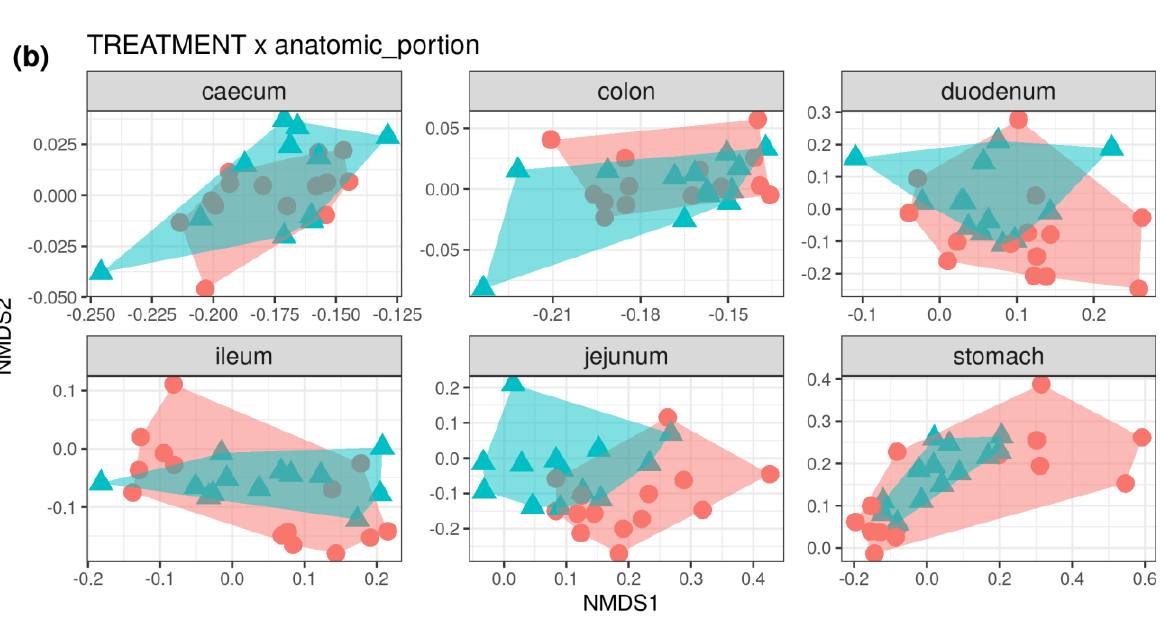
Figure 6. ( a ): Non-metric multidimensional scaling plot of Bray-Curtis dissimilarities estimated from the OTU table. The plots show the first three NMDS dimensions (from left to right: dimensions one and two, one and three, two and three). Control samples in red circles, Goji-treated samples in blue triangles. ( b ): First two dimensions from the non-metric dimensional scaling of Bray-Curtis dissimilarities between control and Goji-treated samples along the digestive tract of rabbits. For the analyses, 14 and 11–13 samples were used for the control and Goji groups,